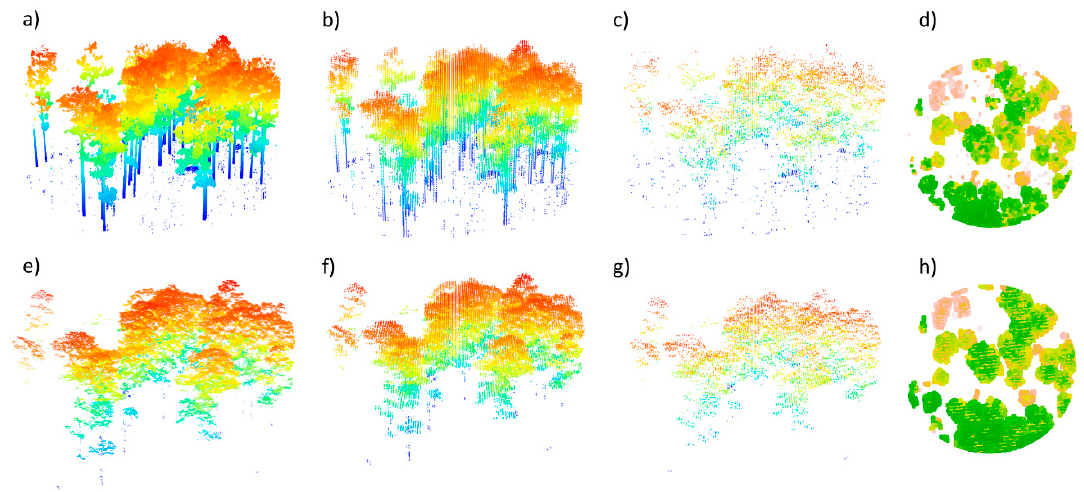
Figure 3. Stages of voxel-based canopy gap estimation, where ( a ) shows the TLS point-cloud data from Transect 1; ( b ) shows the 25 cm voxelized point cloud data; ( c ) shows the thinned point cloud, retaining only voxels that occupy distinct X and Y space; and ( d ) shows a ‘birds-eye’ view of the thinned point cloud. Panels ( e – h ) show the voxel-based canopy gap estimation stages using ALS.